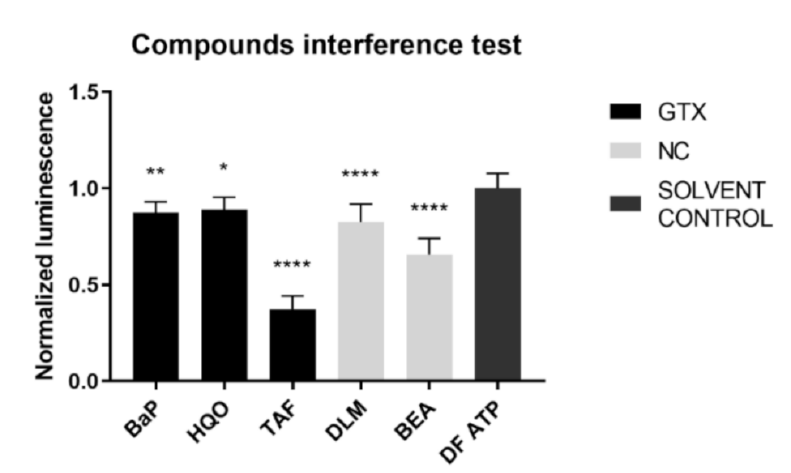
Figure 11. Interference of GTX, NGTX and NC chemicals with the adenosine triphosphate (ATP) luminescence measurement. GTX, NGTC, and NC chemicals were dissolved in a 100 nM ATP solution at their IC 10 concentration ( n = 3 and N = 3). Luminescence was measured and data were normalized by the mean luminescence of the DF ATP control. Significant difference compared to the ATP control was calculated with a parametric one-way ANOVA followed by a Dunnett’s post-hoc test to correct for multiple comparisons. Data are expressed as mean ± standard deviation with * p ≤ 0.05 ** p ≤ 0.01 and **** p ≤